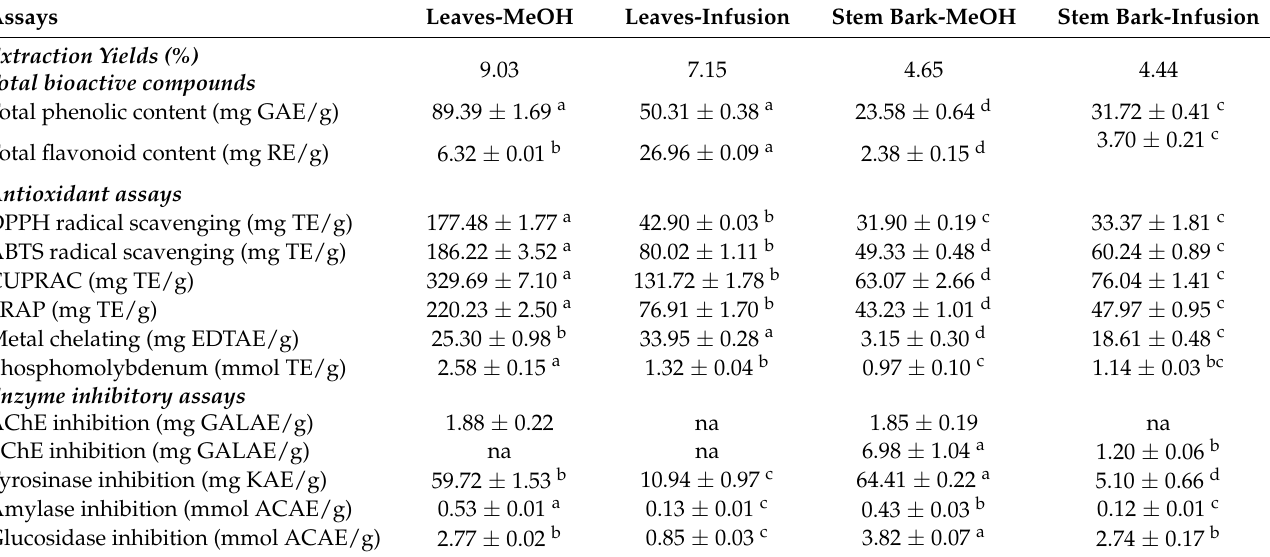
Table 1. Extraction yields, total bioactive components, and antioxidant and enzyme inhibitory effects of the tested